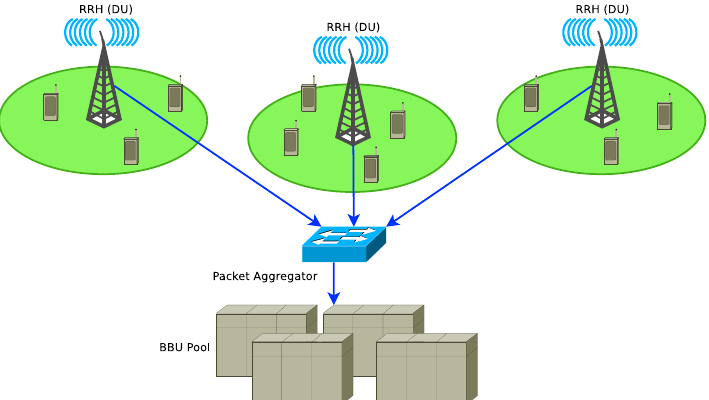
Figure 3. A Cloud Radio Access Network (C-RAN) architecture with packet aggregation at the fronthaul network